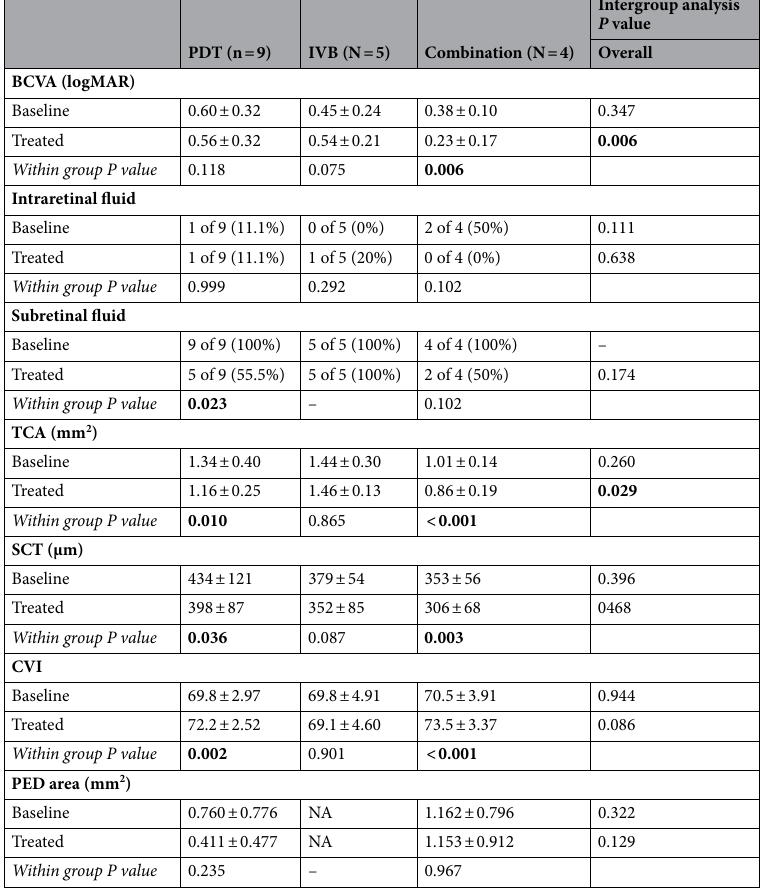
aFIPED N = 14 Alteration of BCVA: − 0.07 ±